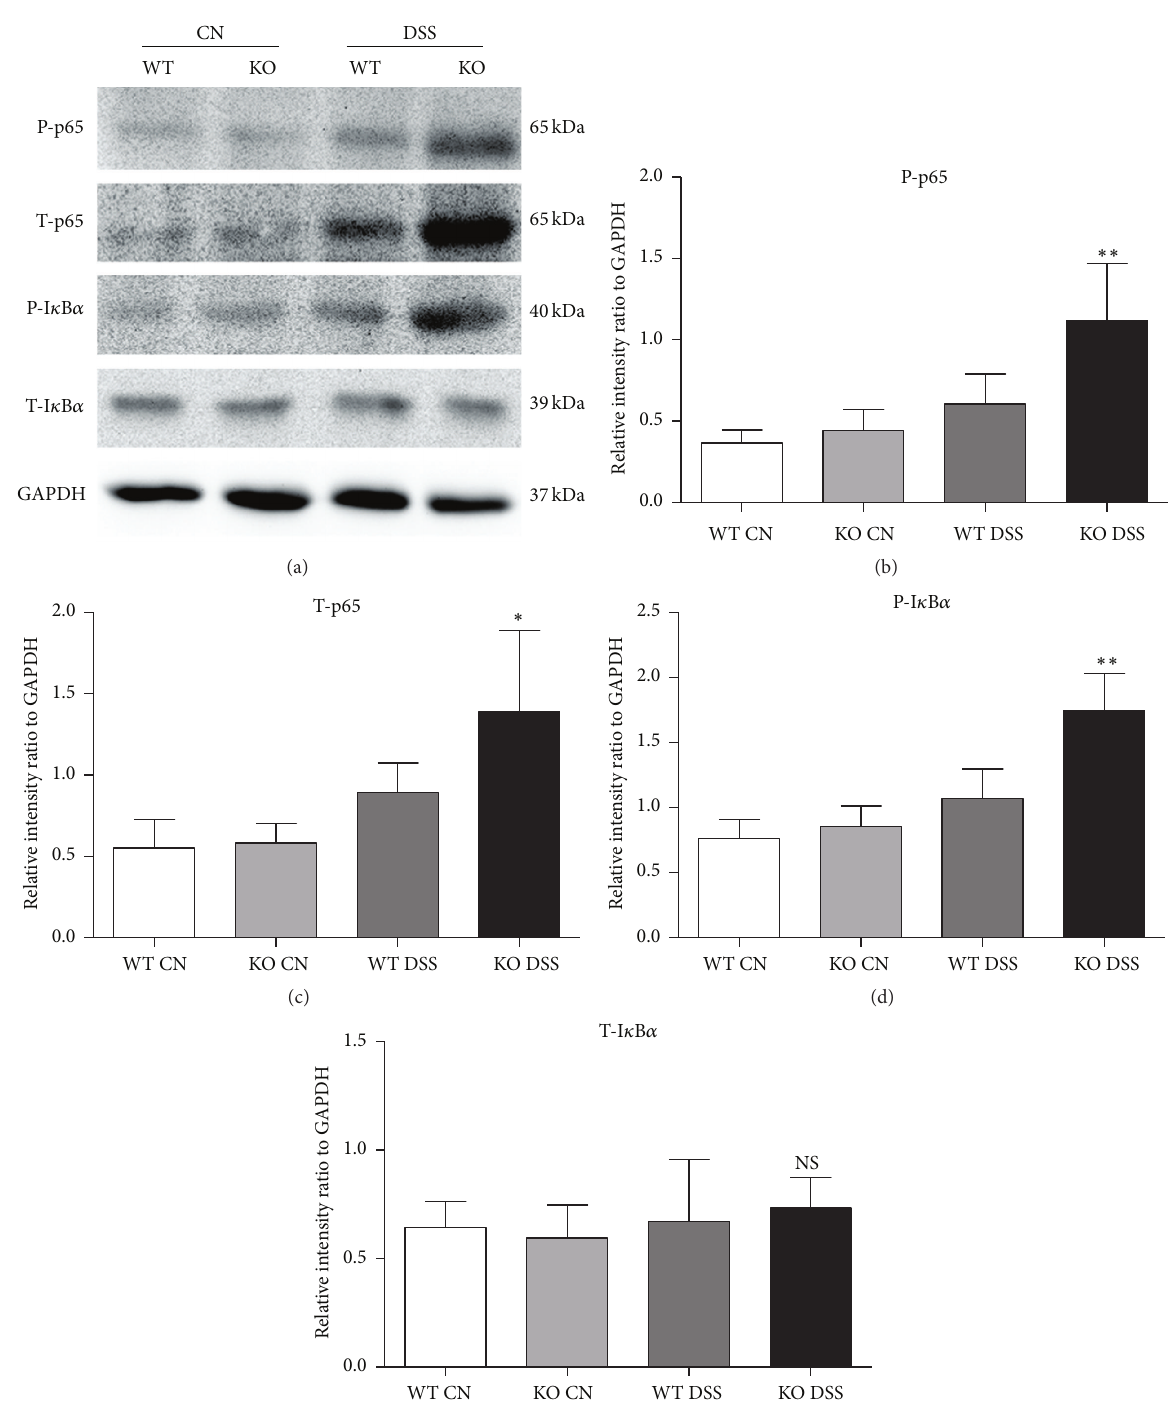
Figure 6: Deficiency in TRAF5 augments the activation of NF- 𝜅 B signaling. The phosphorylated and total protein expression levels of p65 and I 𝜅 B 𝛼 were detected in the colons of TRAF5 KO and WT mice. (a) Representative blots. ((b), (c), (d), and (e)) Quantitative results. The data are representative of 3 independent experiments (mean ± SD). 𝑁 = 4 per group. ∗ 𝑝 < 0.05 versus the DSS-treated WT group; ∗∗ 𝑝 < 0.01 versus the DSS-treated WT group. NS: not significant versus the DSS-treated WT